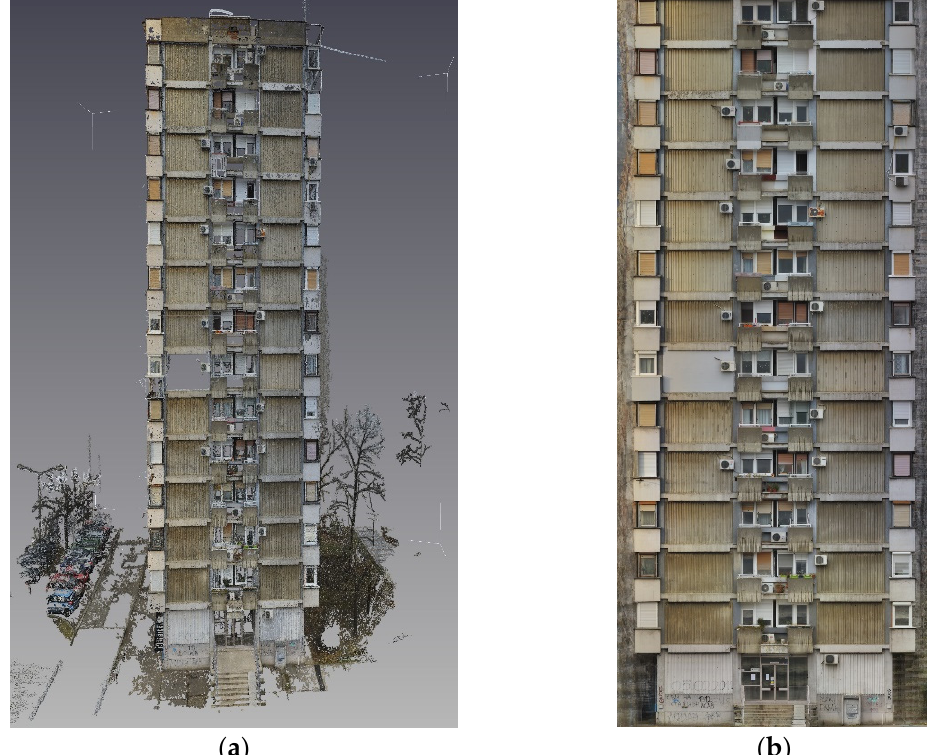
Figure 4. Southeast building façade: generated ( a ) point cloud with over 35 million points and ( b ) orthofaçade with an average GSD of 2.2 mm.